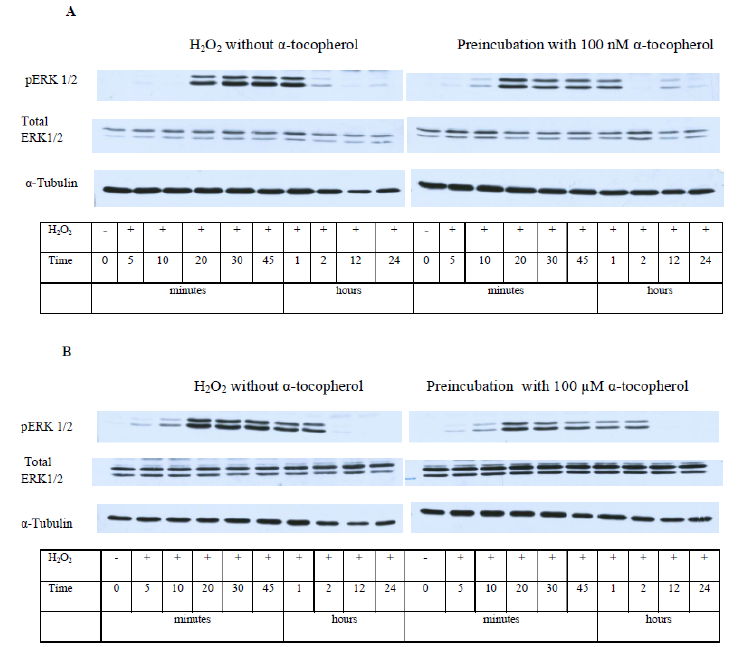
Figure 9. The figure shows the effect of hydrogen peroxide and pre-incubation with α -T on the activity (pERK 1/2 level) and expression of ERK 1/2 in PC12 cells. PC12 cells were pre-incubated with 100 nM and 100 μ M α -T (or without it) for 18 h and then exposed to 0.3 mM H O . The results of immunoblotting obtained in one typical experiment (from 2 2 five experiments made) are shown in ( A , B ), ( A ) 100 nM α -T; ( B ) 100 μ M α -T. The results of five experiments are shown in ( C , D ) as means ± SEM; ( C ) 100 nM α -T; ( D ) 100 μ M O alone, black lines with diamond α -T. Red lines with square data points show effect of H 2 2 O after pre-incubation with α -T. In ( C , D ): HP is an data points show the effect of H 2 2 abbreviation for hydrogen peroxide. alpha-T is an abbreviation for α -tocopherol * the differences are significant according to Students’ paired t test, as compared to the level of O , p < pERK 1/2 in the PC12 cells exposed to α -T and H 2 2